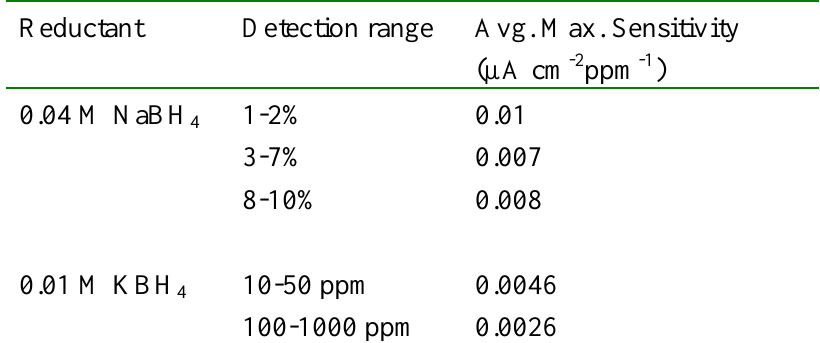
Table 2. A list of average maximum sensitivities of two different sensors in detection range from percentage to ppm